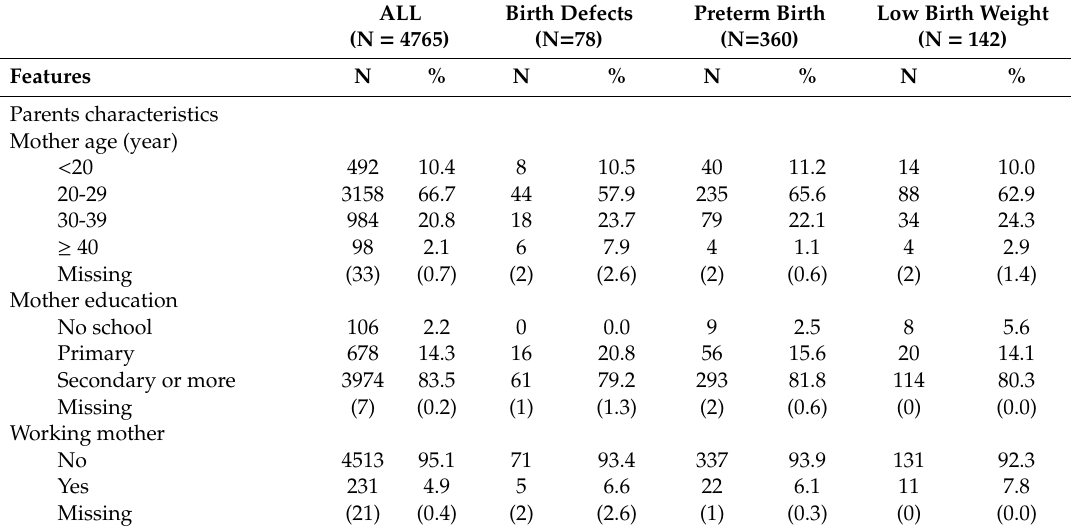
Table 1. Parents’ characteristics and exposures, reproductive history, and delivery